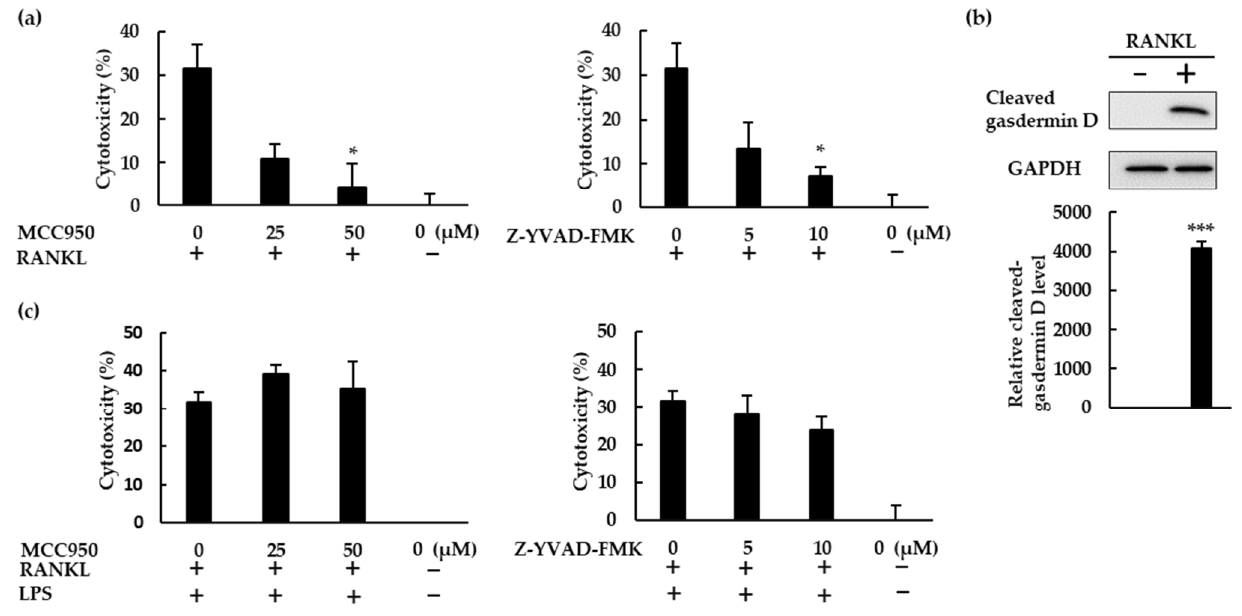
Figure 7. RANKL induced pyroptotic cell death via the NLRP3 inflammasome. ( a ) BMMs were treated with M-CSF (30 ng/mL) and RANKL (10 ng/mL) in the presence or absence of MCC950 or Z-YVAD-FMK for 72 h. ( b ) BMMs were treated with RANKL (0 or 20 ng/mL) and M-CSF (30 ng/mL) for 24 h. Cell lysates were then prepared and subjected to SDS-PAGE followed by Western blotting using anti-gasdermin D and anti-GAPDH antibodies. Relative levels of protein bands were determined using ImageJ software. ( c ) BMMs were treated with RANKL (5 ng/mL) and M-CSF (30 ng/mL) for 48 h, then stimulated with 10 ng/mL LPS in the presence or absence of MCC950 or Z-YVAD-FMK for 24 h. Following incubation, we quantified the level of cytotoxicity by measuring lactate dehydrogenase (LDH) concentrations in the culture supernatant. The results are expressed as the means ± SE of triplicate assays and the images are representative of three independent experiments. * p < 0.05, *** p < 0.001 compared with the control.